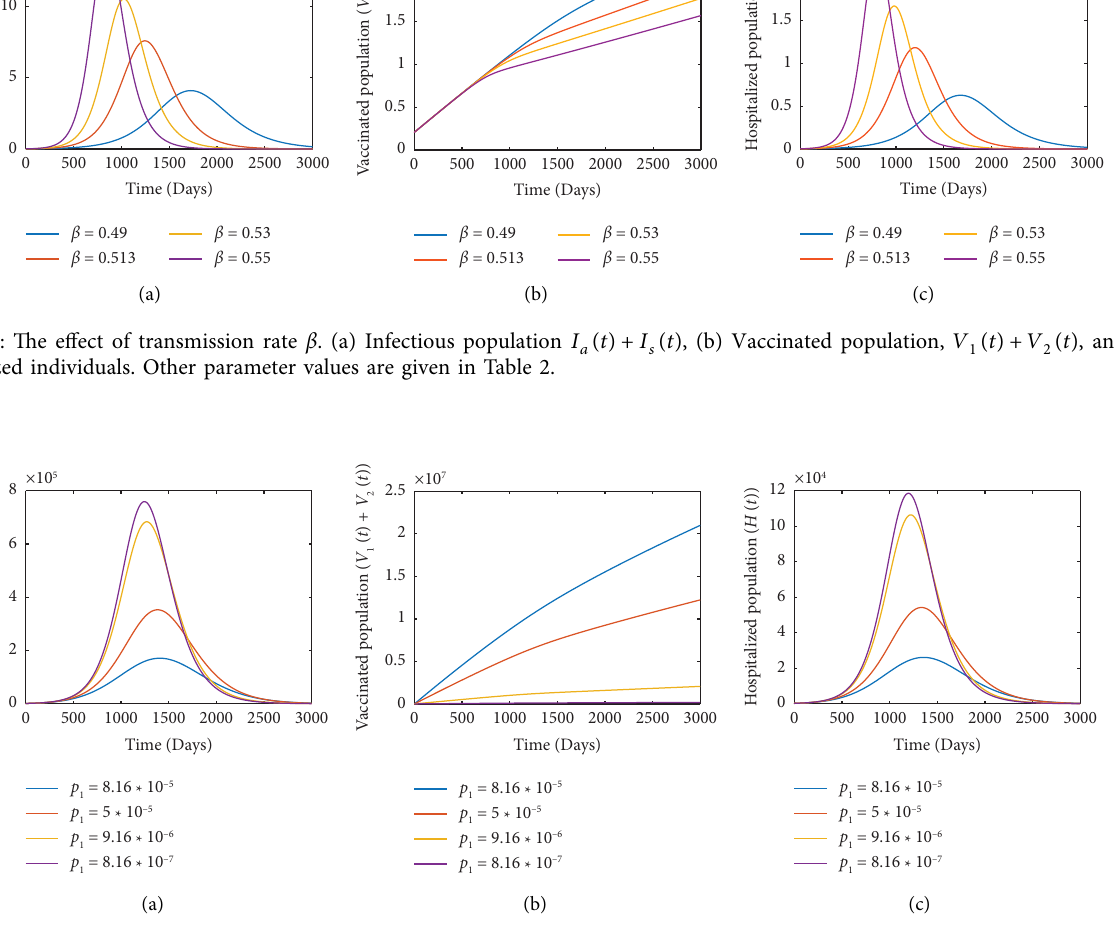
: on the dynamics of infectious population (a), vaccinated population (b), and 1